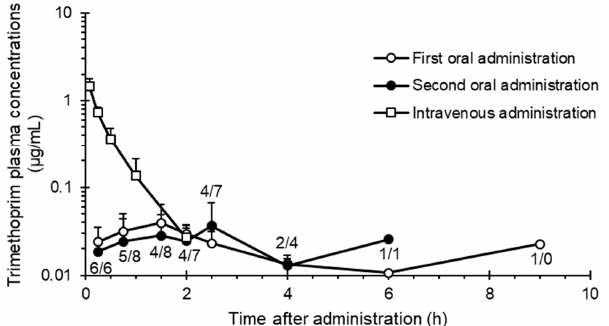
Figure 2. TMP plasma concentrations (mean ± SD) after single administrations of a SDM-TMP combination orally (Trisulmix ® Liquid, 24.7 mg/kg SDM + 5.3 mg/kg TMP, open circles = first oral administration, closed circles = second oral administration) or intravenously (Trisulmix ® Injectable, 24.7 mg/kg SDM + 5.3 mg/kg TMP, open squares) to eight lambs. For the intravenous administrations, concentrations were above the LOQ (Limit of Quantification) of 0.01 µg/mL from 0.08 to 2 h for all lambs and below the LOQ for all the other sampling times. For the oral administrations, the number